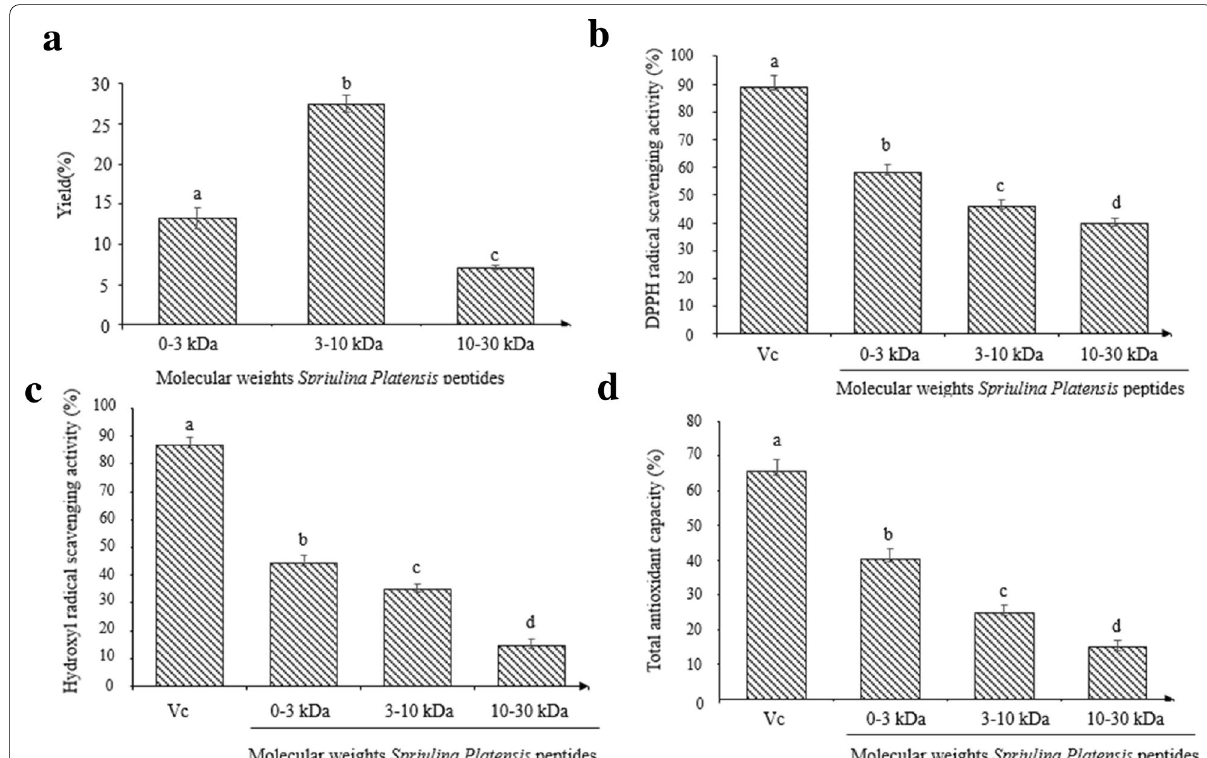
Fig. 1 Antioxidant activities of the papain hydrolysates of Spirulina platensis peptides. a Preparation yield of the three different molecular weights of Spirulina platensis peptides. b DPPH radical scavenging activity of the three different molecular weights of Spirulina platensis peptides. c Hydroxyl radical scavenging activity of the three different molecular weights of Spirulina platensis peptides. d Total antioxidant capacity of the three different molecular weights of Spirulina platensis peptides. Vc as positive control. The bar graph represents mean